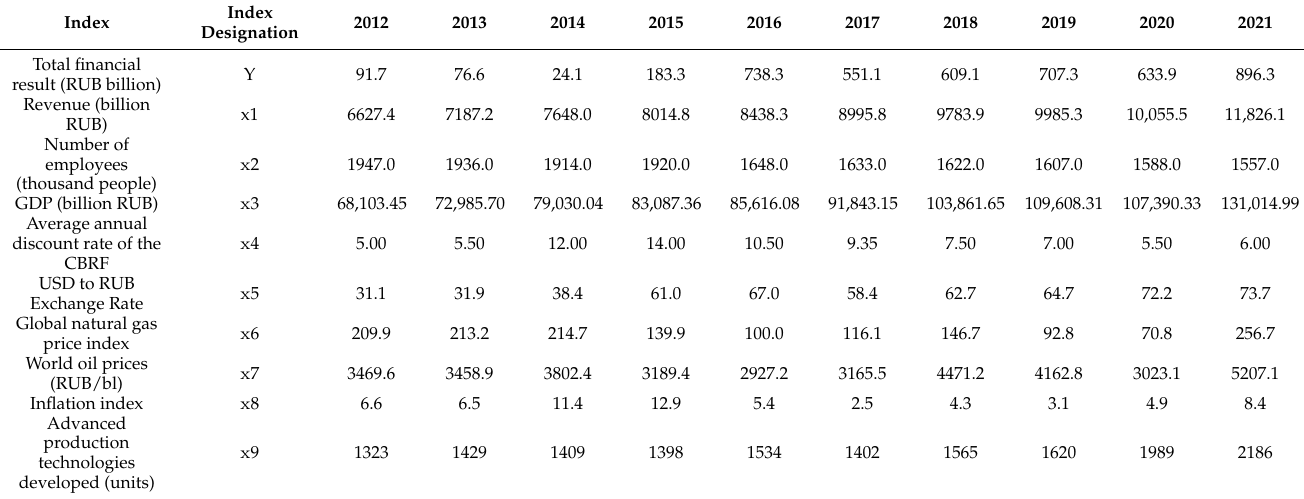
Table 1. Baseline data for correlation analysis, 2012–2021 (developed by the authors on the basis of